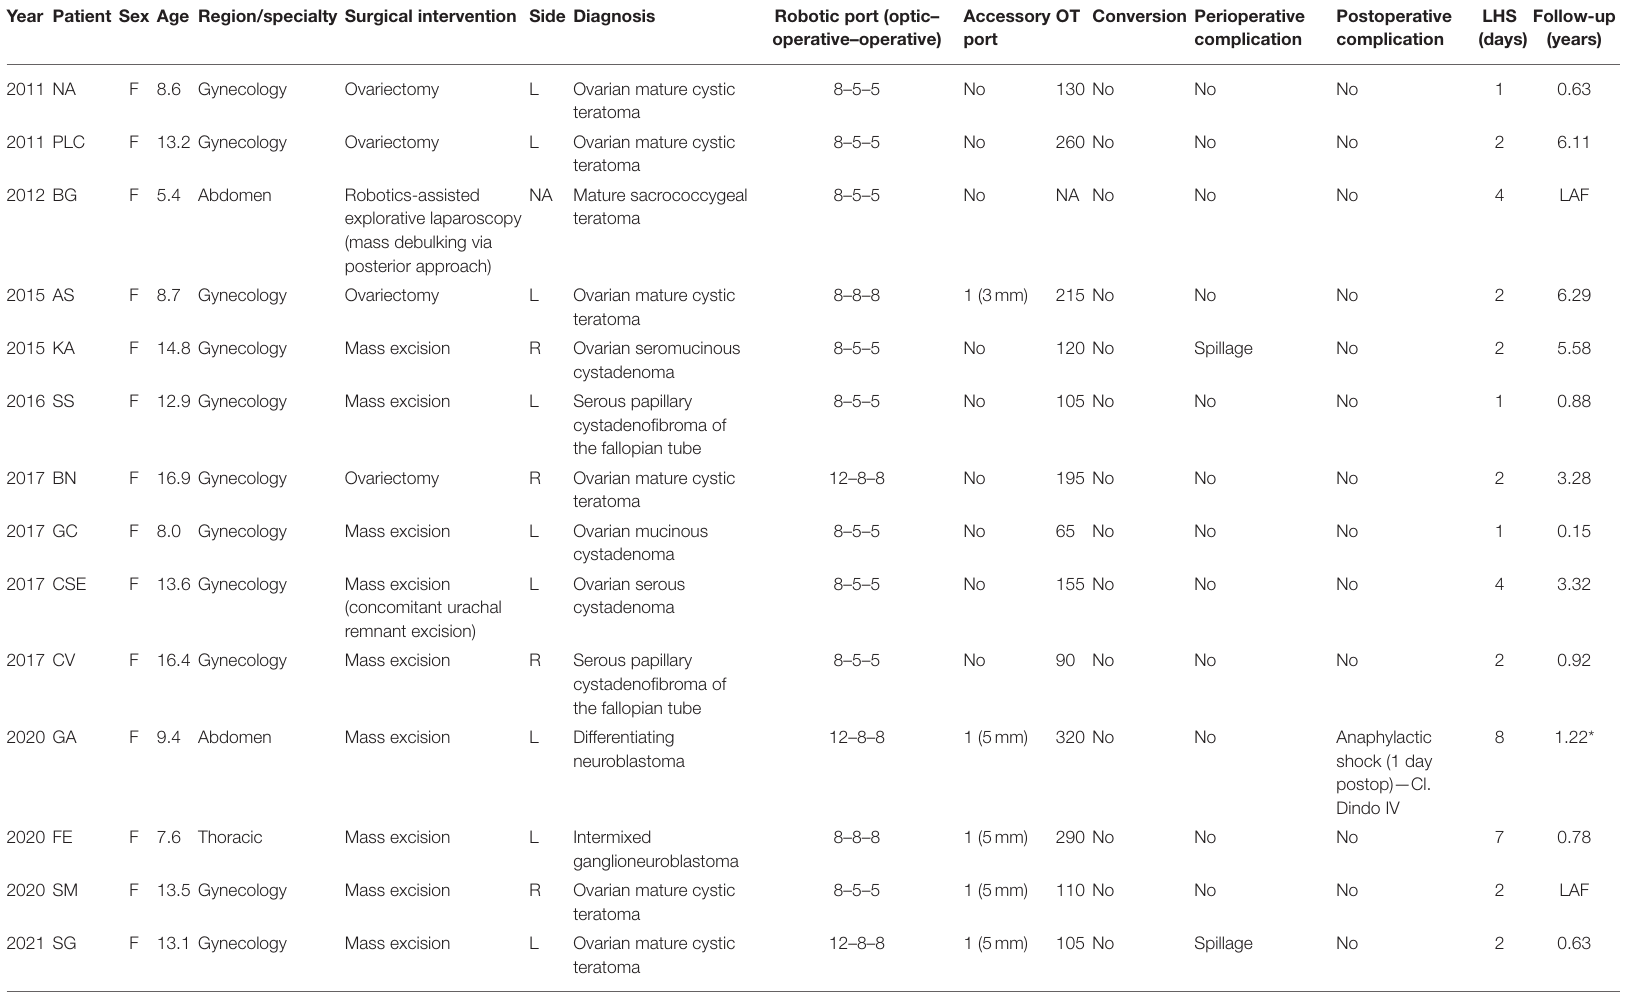
RAS, robotics-assisted surgery; OT, operation time; LHS, length of hospital stay. * Neuroblastoma localization in a supraclavicular lymph node at 6 months postop treated